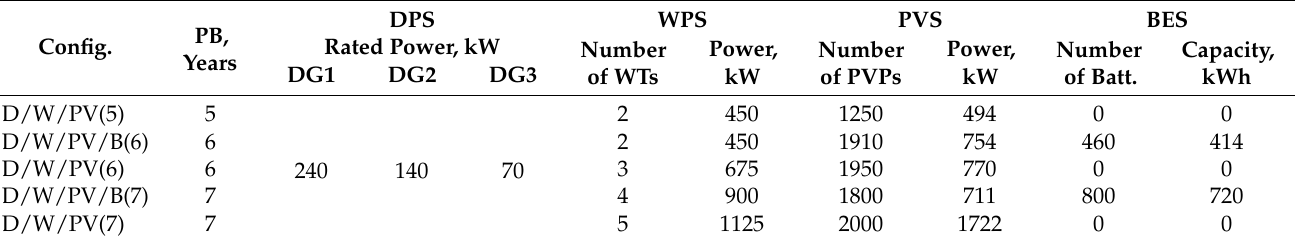
Table 9. Optimal parameters of the HES configuration with the additional constraint of PB.